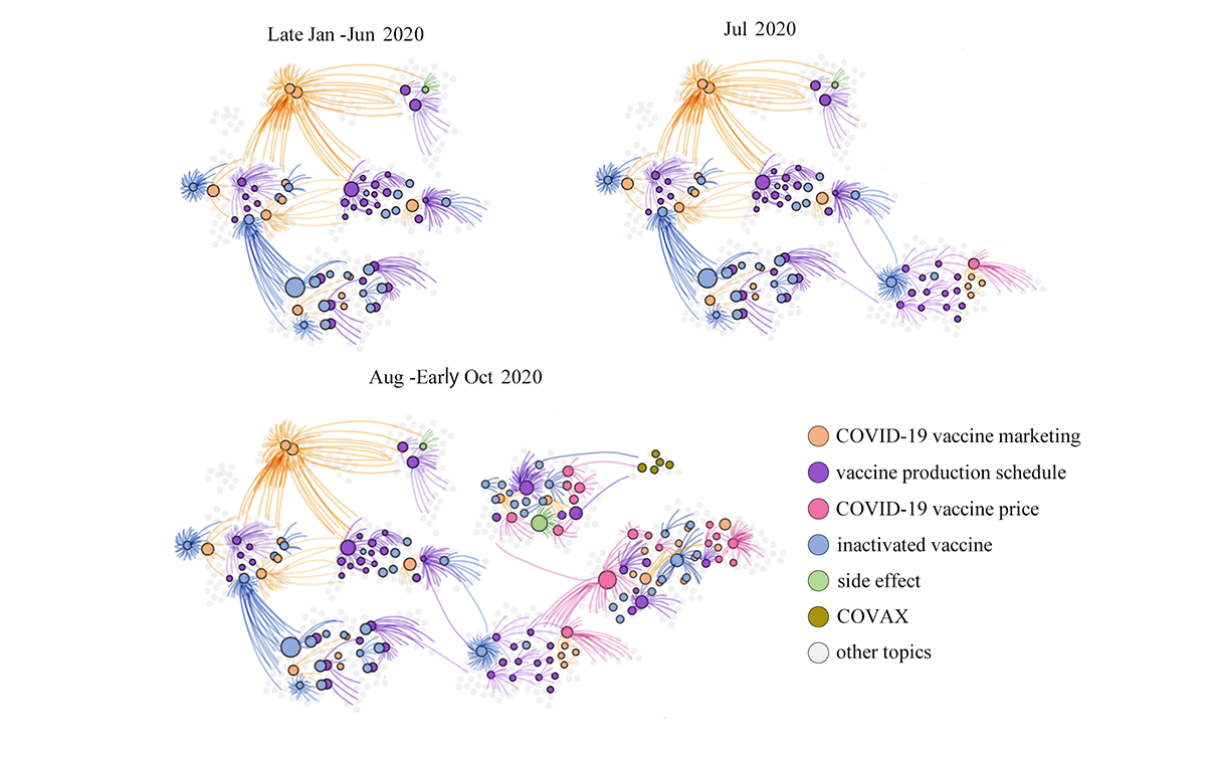
Figure 2. The landscape of public opinion transmission on vaccine-related topics. The colored dots represent the seven main topics. The lines between them represent mutual influence, and the density of the lines represents the degree of